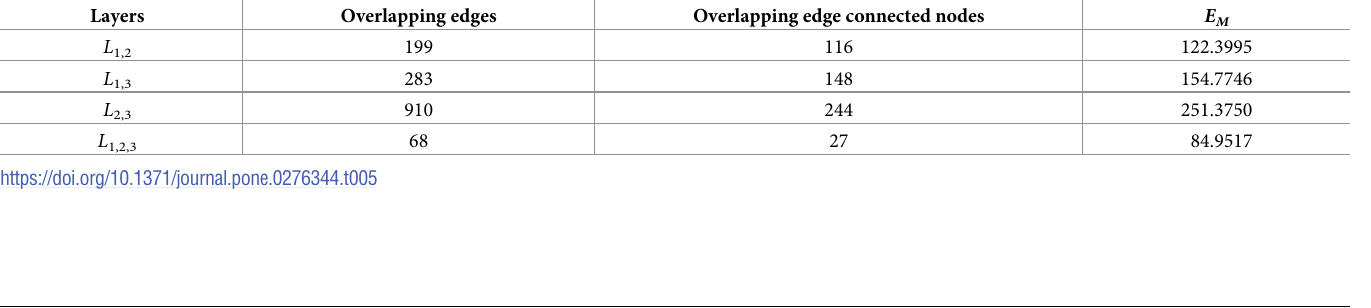
Table 5. Structure entropy of overlapping links between layers of C. elegans multiplex network.